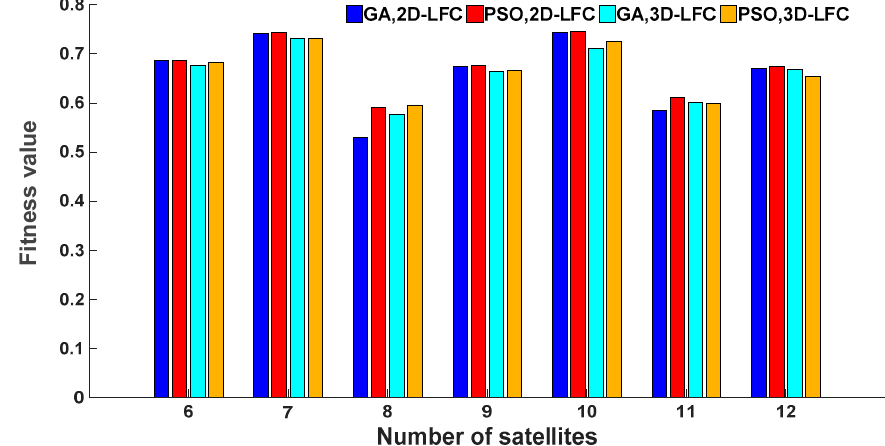
Figure 3. Fitness values of the optimal configurations for 2D-lattice flower constellation (2D-LFC) and 3D-LFC composed of 6-12 satellites based on Genetic Algorithm (GA) and Particle Swarm Optimization (PSO) algorithms.